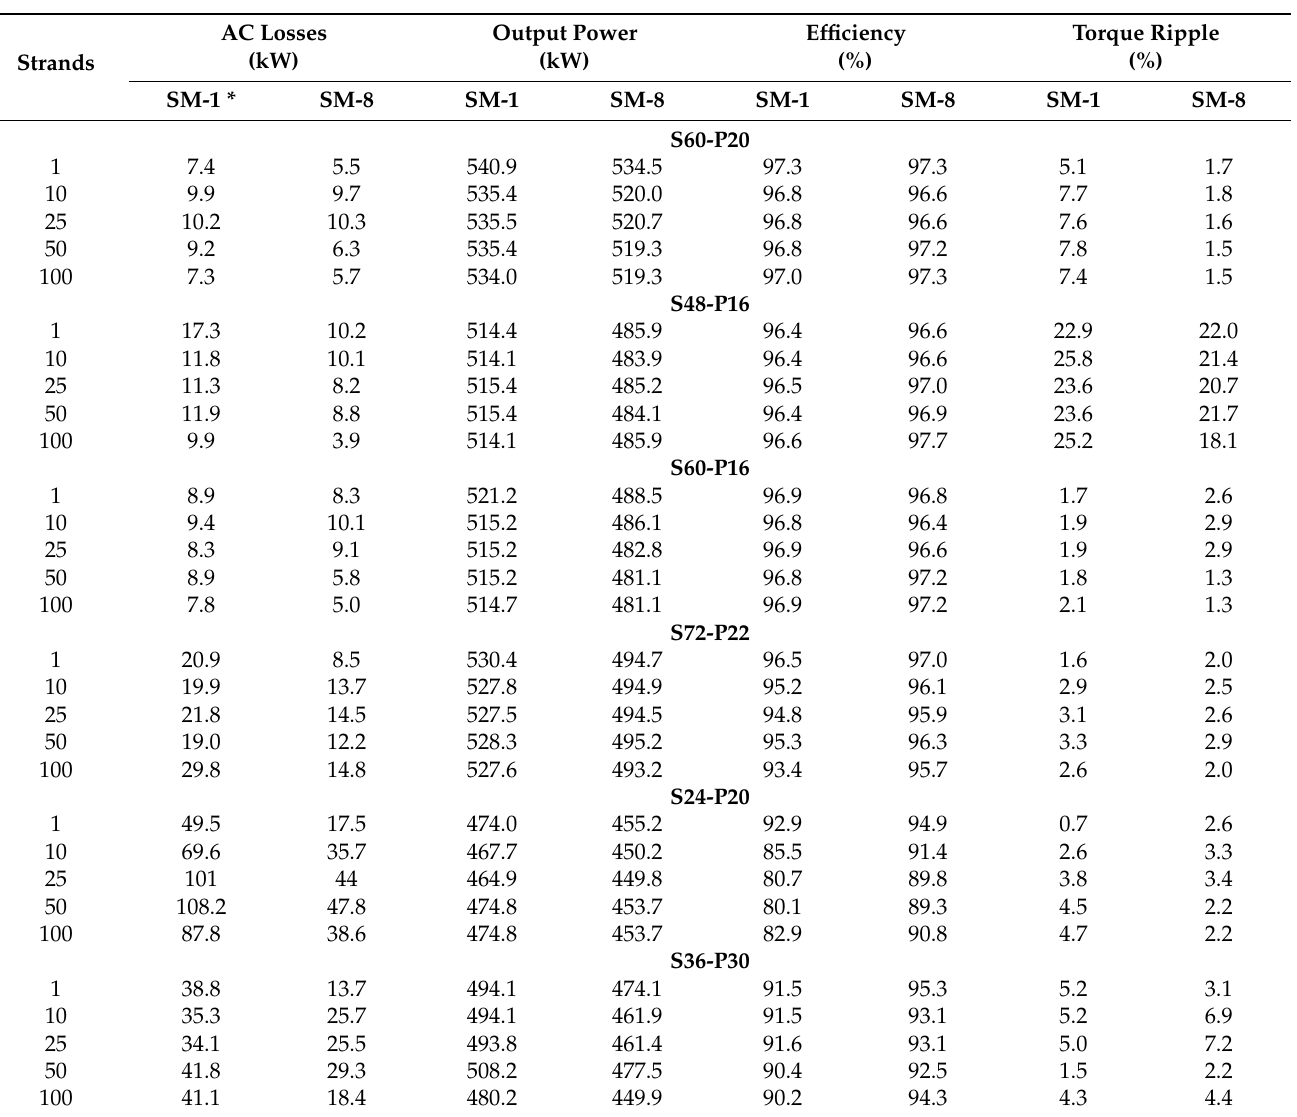
Table 9. Semi-magnetic slot wedge